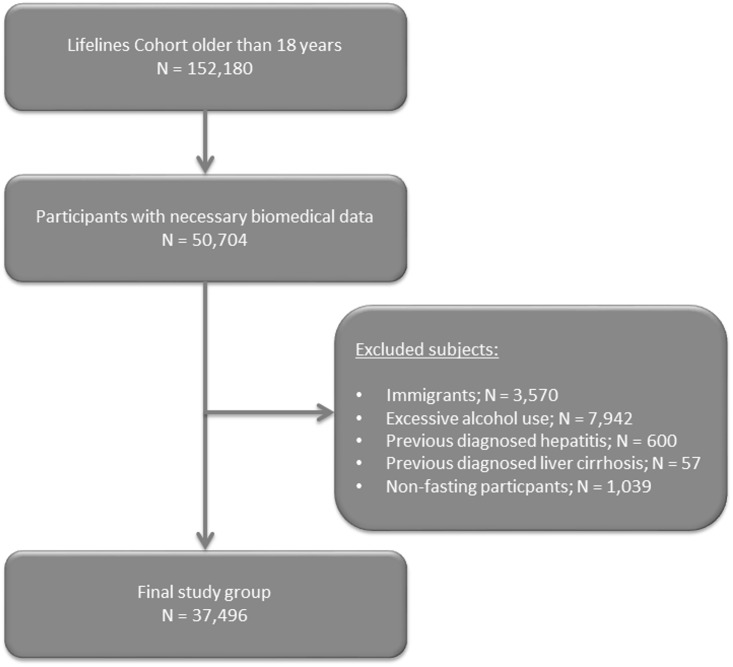
Flow chart of the study population.